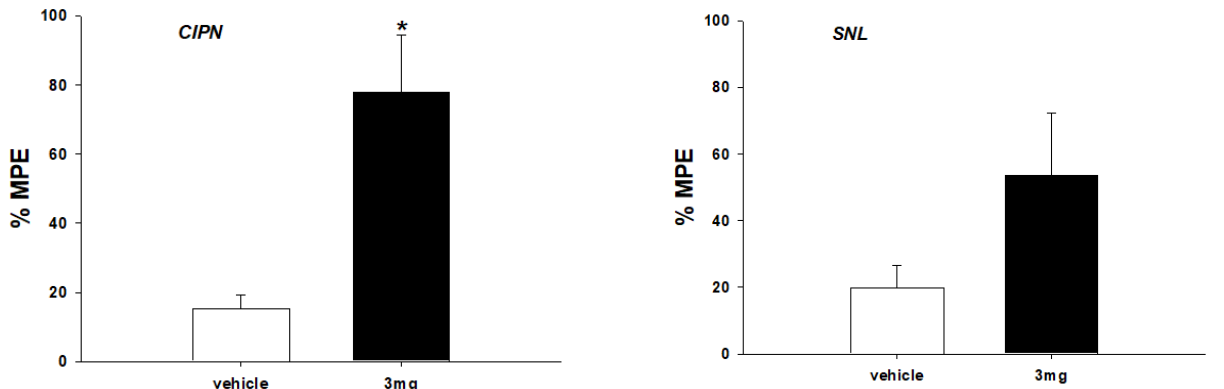
Figure 5. Antiallodynic effect of compound 14h in animal pain models. Each bar represents the mean ± SEM of five rats. * p < 0.05, compared with vehicle.